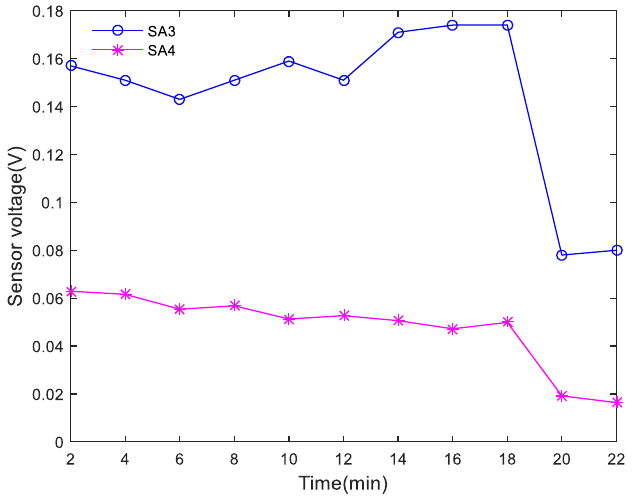
Figure 14. Peak curve of the amplitude of each received SA signal for Composite specimen II .